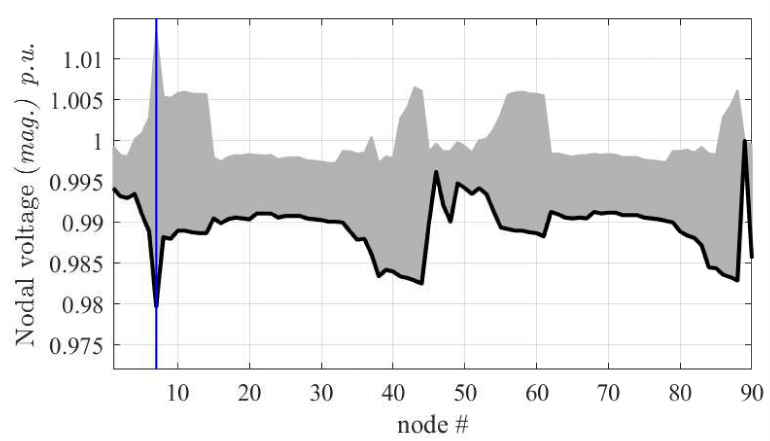
Figure 9. Voltage profile of the Test90 radial network. Solid line: solution without DGs, gray curves: 1000 Monte Carlo simulations where the DGs are varied in the range between disconnection and maximum supply rating.